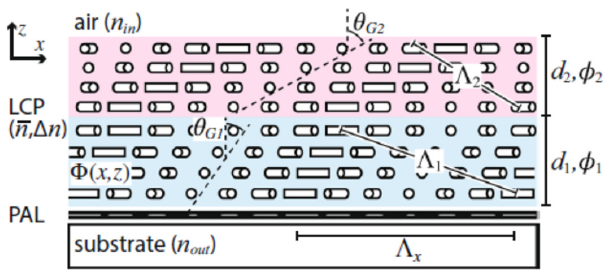
Figure 16. Double-layer twisted Bragg grating [84]. Reprinted with permission from Ref. [84]. 2018 Spring Nature.